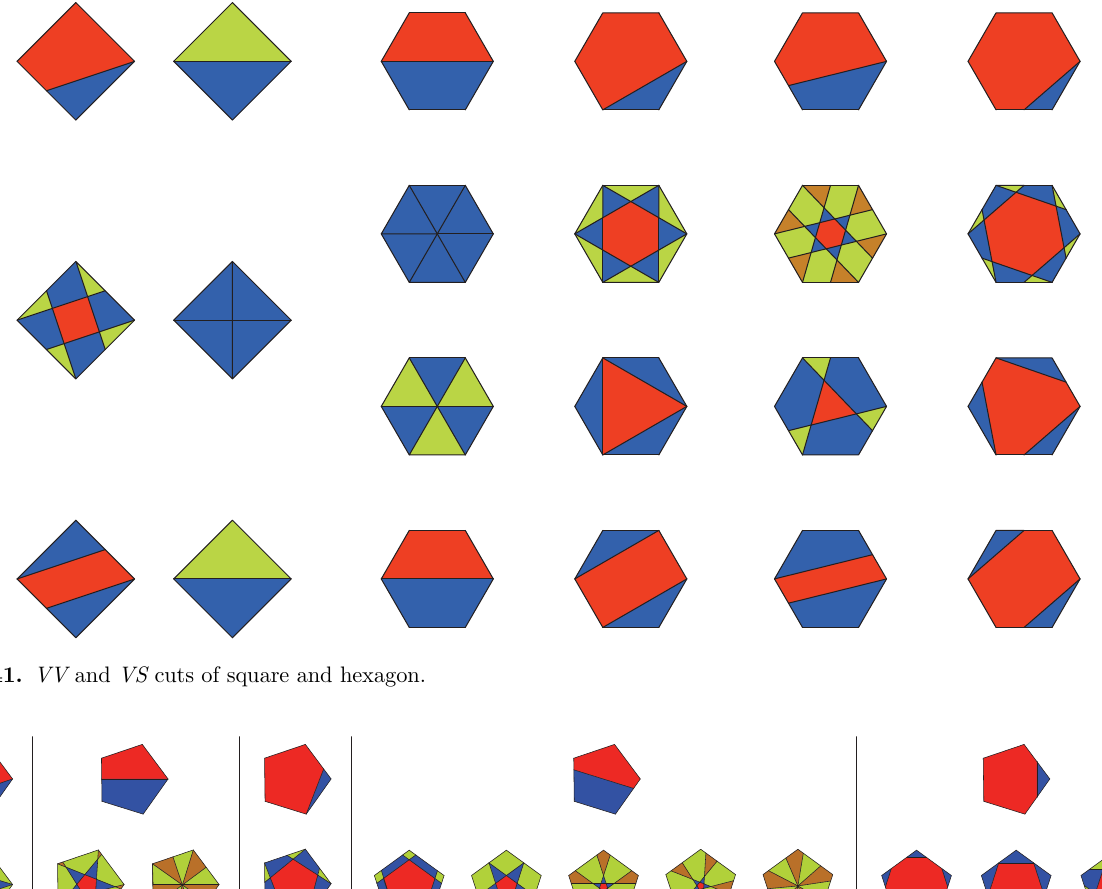
Figure 42. All possible cuttings of a pentagon via VV , VS and SS